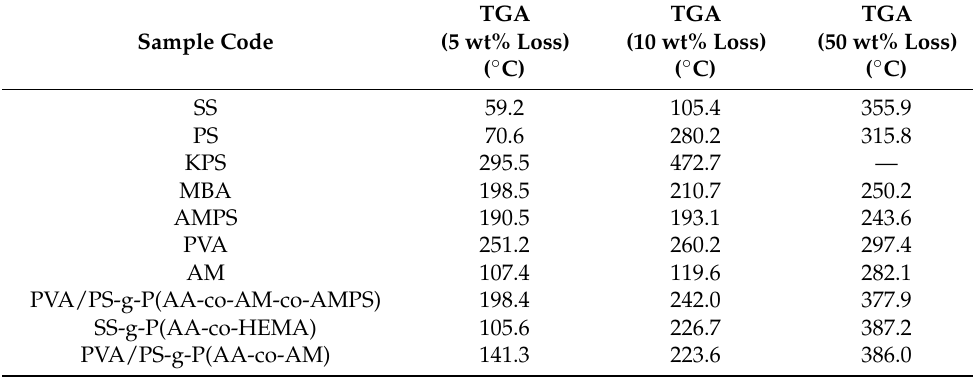
Table 1. The mass loss results derived from thermogravimetric analysis